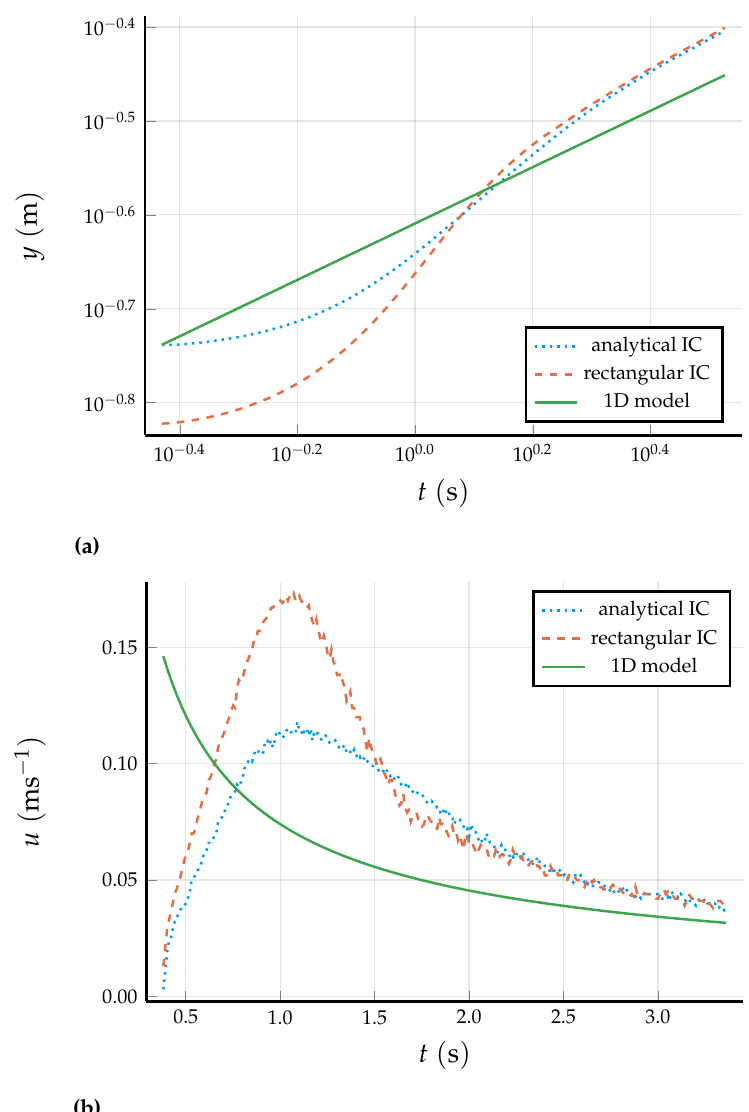
Figure 5. ( a ) Front propagation for two baseline 3D simulations and the 1D flow model. The analytical and rectangular initial conditions used have the same mass. ( b ) Propagation velocity u for the same 3D simulations and 1D model. A lag is observed as momentum builds, and results in overshoot at the nose of the advancing front where distance is measured in ( a ). Numerical calculation of front velocity reveals convergence in ( b